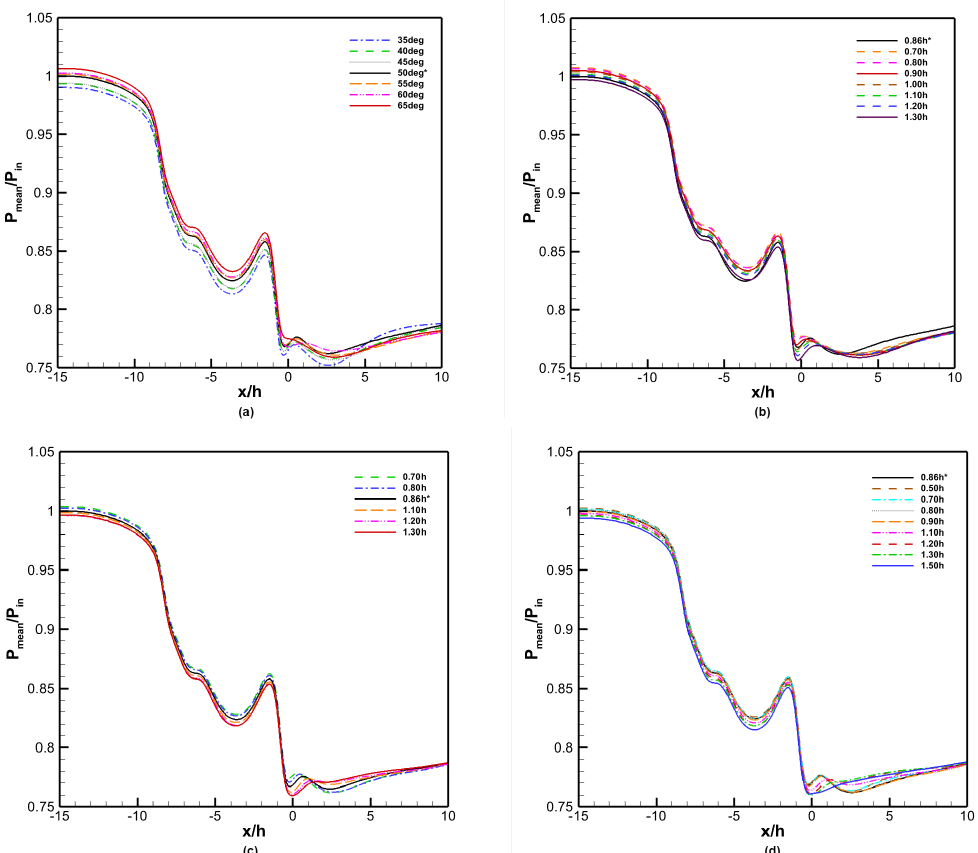
Figure 9. Mean pressure along the centerline nondimensionalized with the inlet pressure, P in , Baseline for ( a ) Angle, ( b ) Curvature, ( c ) L-both and ( d ) L-top.